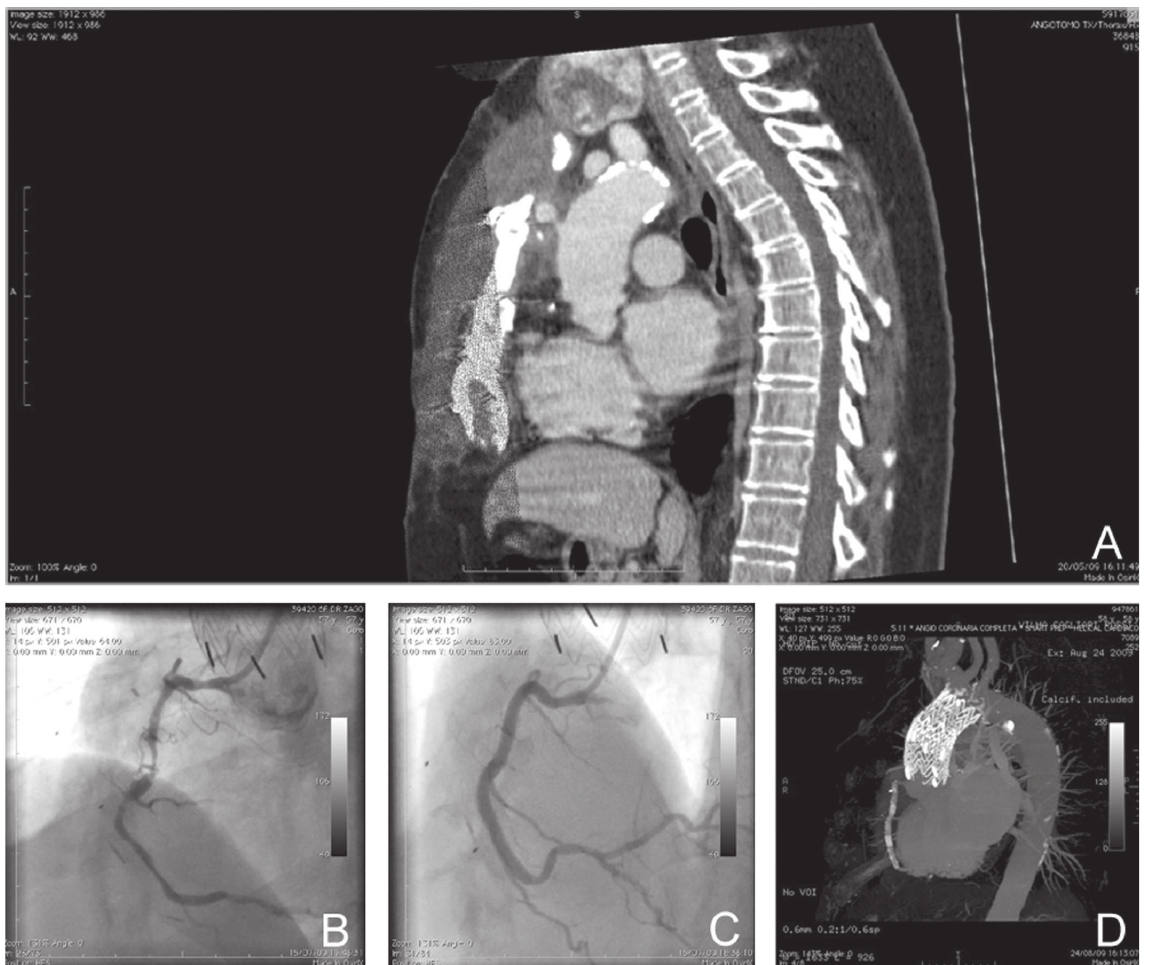
Fig. 1 – A: Pseudoaneurysm of ascending aorta. B: RCA lesions. C: Three stents implanted in RCA. D: Postoperative CT shows that three stents and two extension cuffs are well positioned. CT: computed tomography, RCA: right coronary